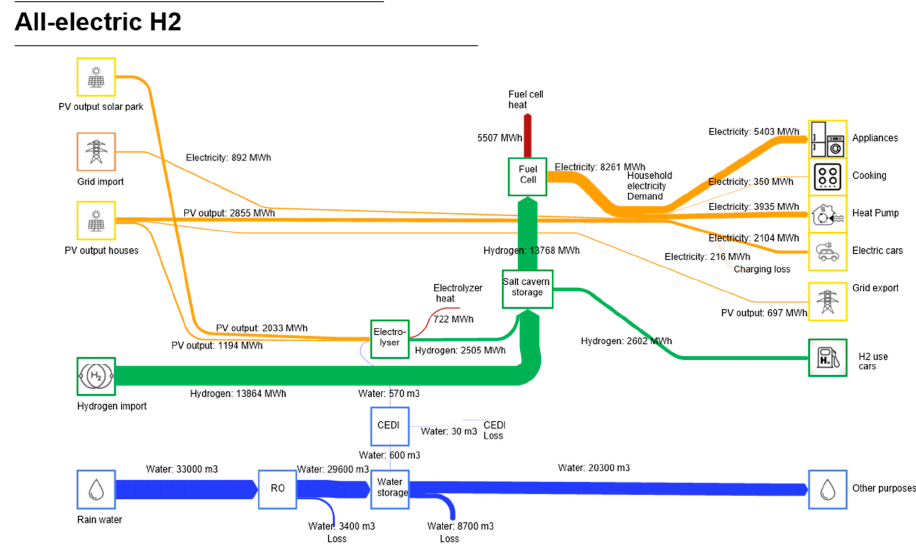
Figure 8. Sankey diagram of the yearly energy and water flows in the all-electric H 2 system. Connections between water and hydrogen (for hydrogen production) and hydrogen and electricity (electrolyzer and fuel cell) create a more integrated system in this scenario. The houses have electricity as their only direct energy source. 2885 MWh or 24% of their electricity demand is fulfilled by direct use of local PV production, and 892 MWh or 7% is imported from the electricity grid. The remainder of the electricity demand is fulfilled by the import of hydrogen and local conversion of hydrogen to electricity by a fuel cell (8261 MWh or 69%). Local electricity production that could not be used directly is first converted to hydrogen (3227 MWh), and if the electrolyzer is working at full capacity, the remainder is exported to the grid (697 MWh).